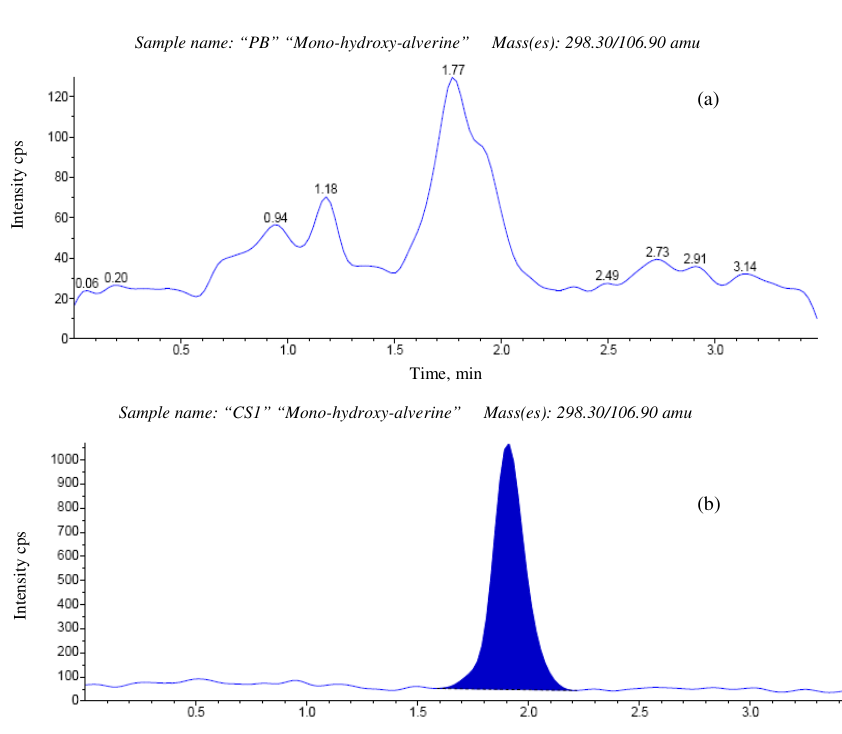
Figure 6. MRM chromatograms obtained from human plasma (a) blank and (b) plasma spiked with MHA at lower limit of quantification (0.060